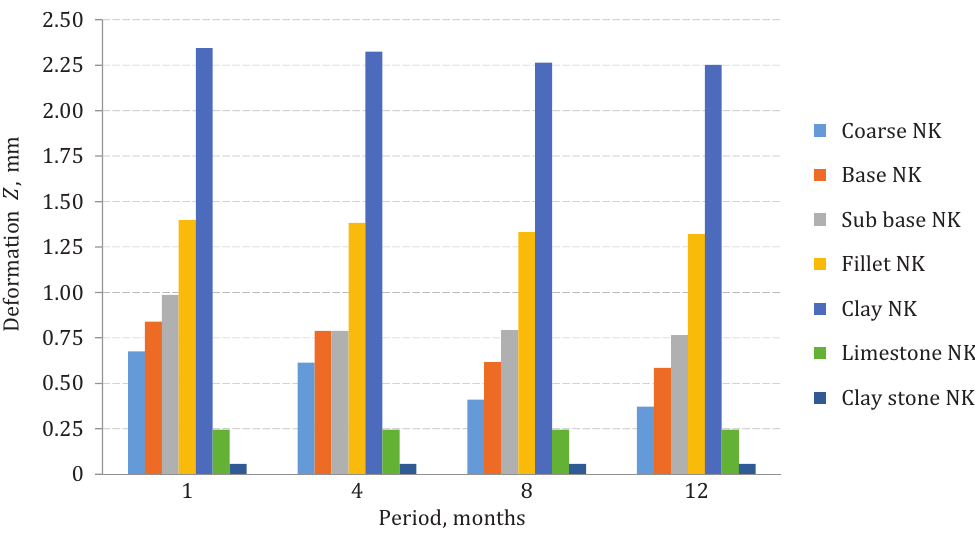
Figure 18. Lateral deformation ( z )-time changes of the layers for NK